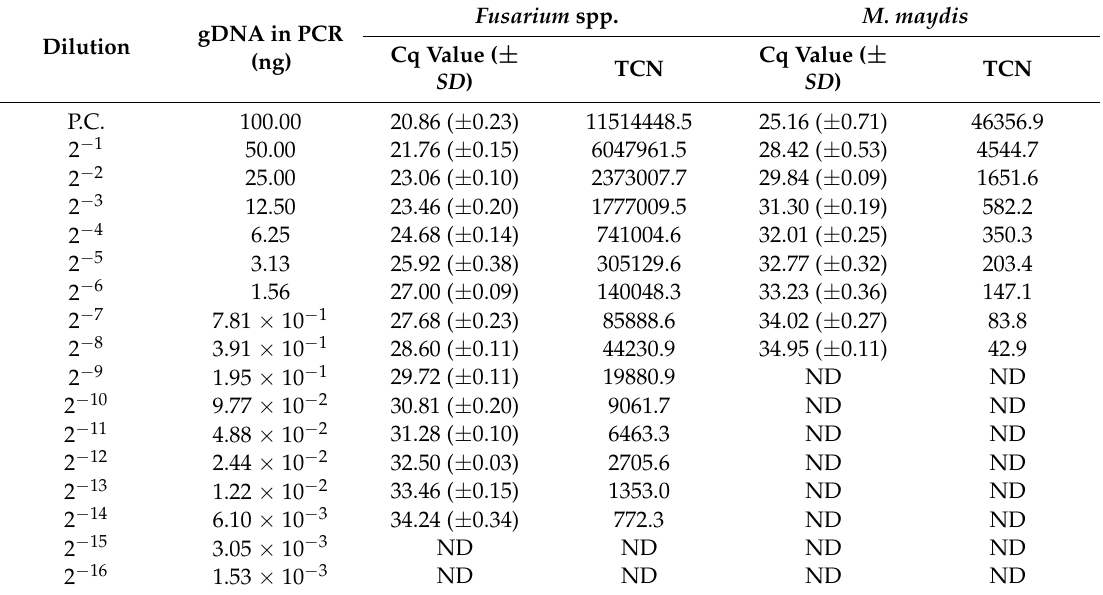
Table 2. Sensitivity of the TaqMan qPCR assays. Serial dilutions of gDNA from Fusarium spp. and Magnaporthiopsis maydis using the corresponding TaqMan assay. The lowest amount of detection for both assays can be observed. Data are expressed as Cq values and target copy number. P.C.: